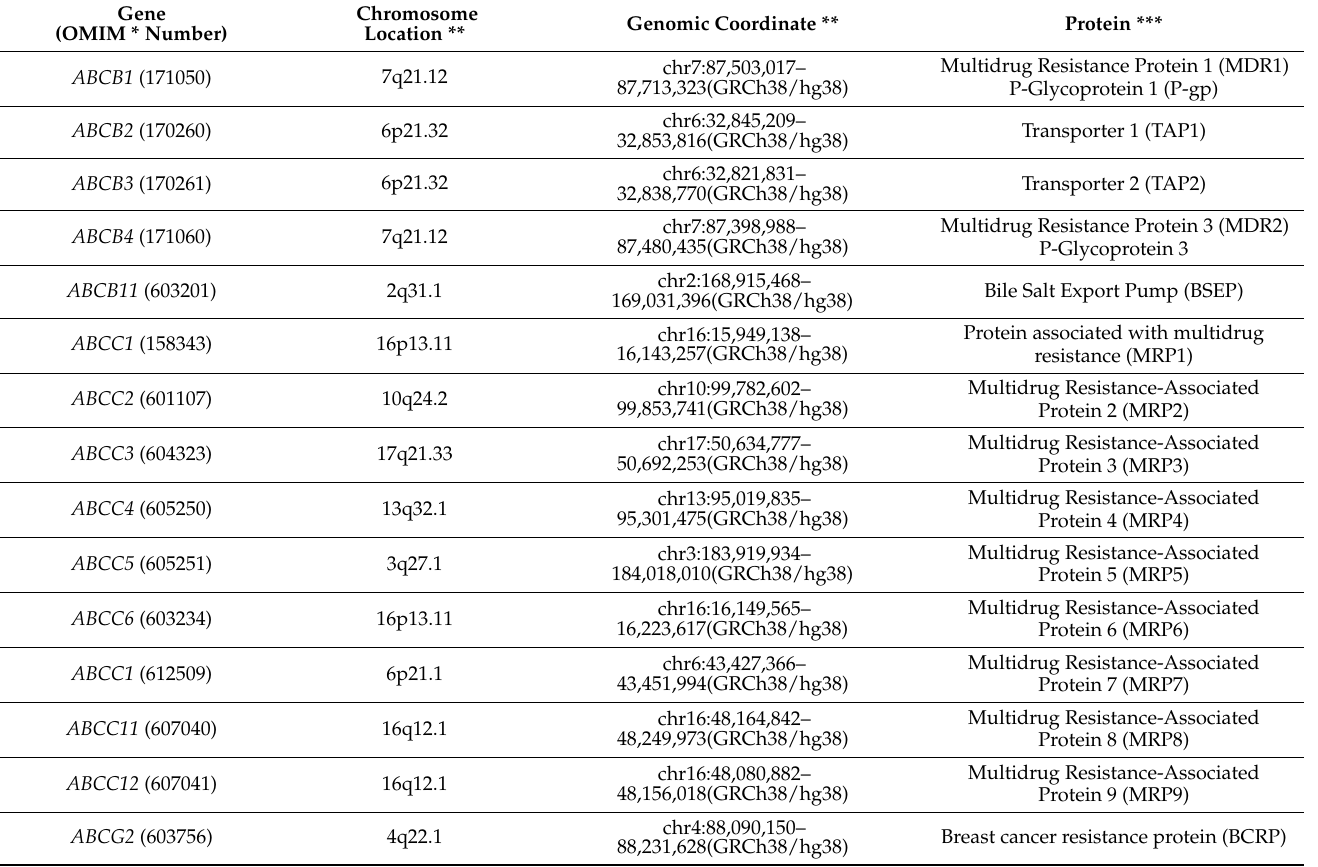
Table A6. Transporter proteins and their encoding